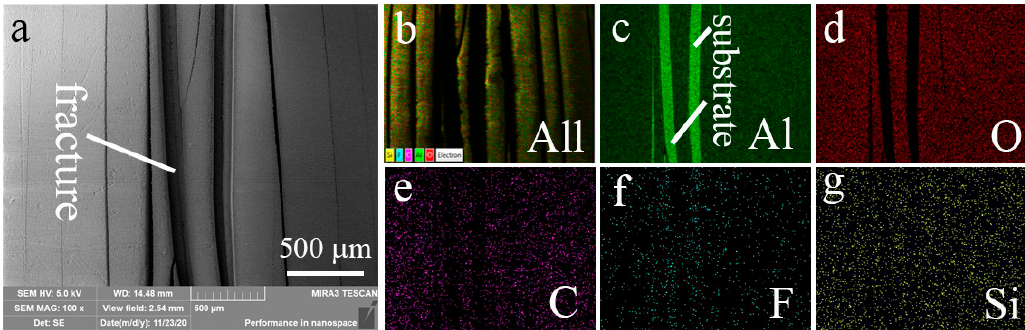
Materials 2020 , 13 , x FOR PEER REVIEW Figure 13. Variation curve of bending strength with the bending displacement achieved via bending test.